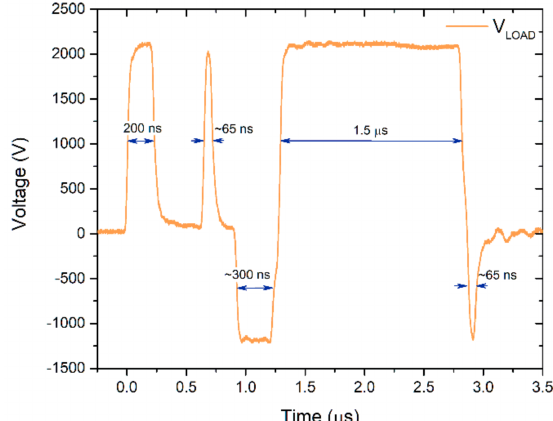
Figure 7. An exemplary arbitrary pulse waveform that can be generated using the proposed electro- porator, R LOAD = 1 k Ω .